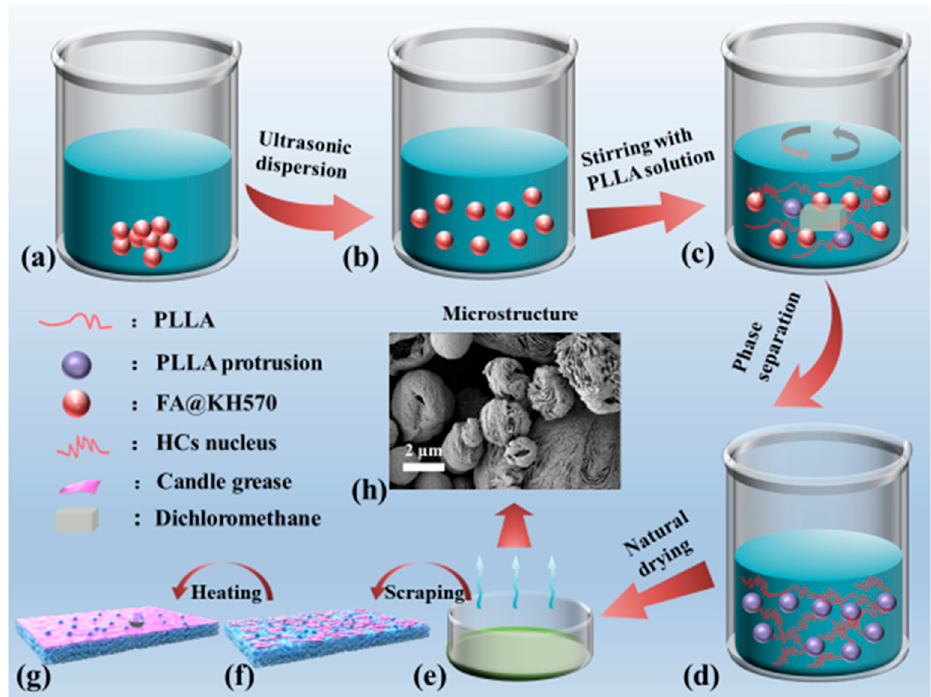
Figure 1. Schematic diagram of the preparation procedure of PLLA/FA@KH570 composites. ( a ) FA@KH570 in dichloromethane, ( b ) FA@KH570 dichloromethane dispersion, ( c ) PLLA/FA@KH570 dichloromethane solution, ( d ) PLLA/FA@KH570 gel, ( e ) PLLA/FA@KH570 composite, ( f ) candle-scraped PLLA/FA@KH570 composite, ( g ) heated candle-scraped PLLA/FA@KH570 composite, ( h ) Microstructure of PLLA/FA@KH570 composite.